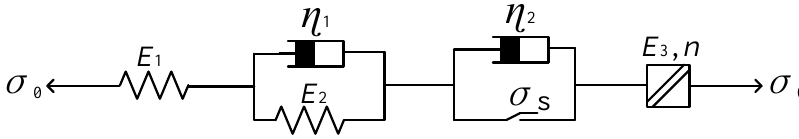
Figure 10. Creep disturbance model.